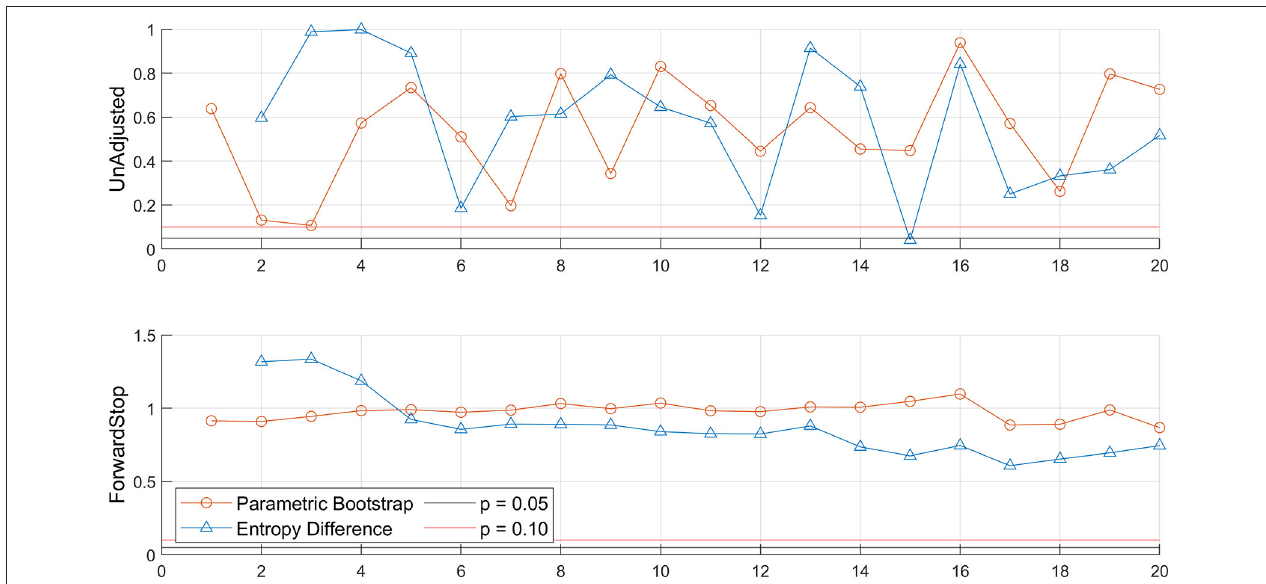
FIGURE 3 | Example demonstrating GEVr Unadjusted p -values (top panel) and ForwardStop (bottom panel) results based on the Parametric Bootstrap and Entropy Difference tests for r = 1–20, as defined in Bader et al. (2017). Following the guidelines outlined for the current study, optimum r = 14. Skew surge data for the NOAA Lewes tide gauge over